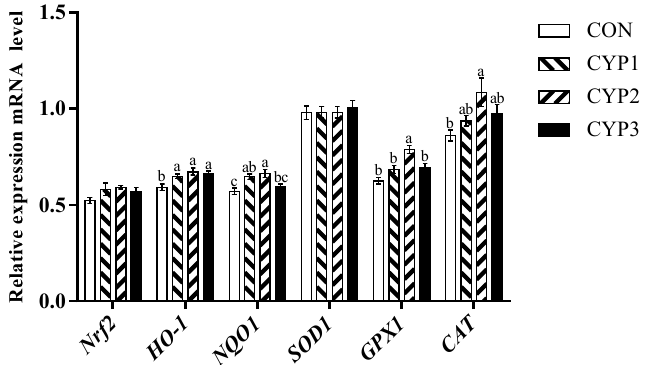
Figure 2. The Nrf2 , HO-1 , NQO1 , SOD1 , GPX1 , and CAT mRNA expressions of breast muscle in broilers. Different lowercase superscripts indicate significant differences ( p < 0.05). CON = control diet; CYP 1 = control diet adds 250 mg CYP per kilogram; CYP 2 = control diet adds 500 mg CYP per kilogram; CYP 3 = control diet adds 1000 mg CYP per kilogram. Nrf2 , nuclear factor-erythroid 2-related factor 2; HO-1 , heme oxygenase 1; NQO1 , quinone oxidoreductase; SOD1 , superoxide dismutase 1; GPX1 , glutathione peroxidase 1; CAT , catalase.